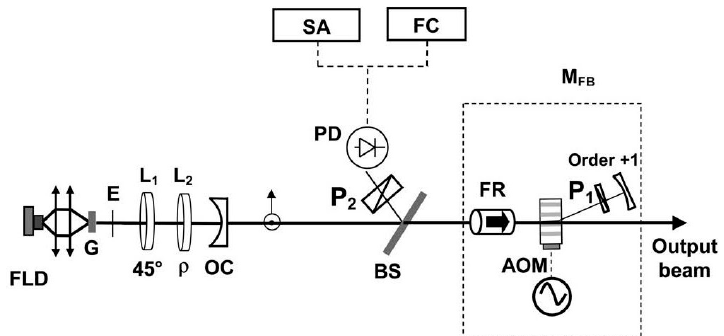
Figure 37. Schematic of self-injection stabilization process for 1.53 μ m dual-frequency phosphate glass laser [51] . FLD: fiber-pigtailed laser diode; G: Yb:Er glass plate; E: intracavity etalon; L 1 and L 2 : quarter-wave plates; P 1 and P 2 : linear polarizers; OC: output coupler; BS: beam splitter; FR: Faraday rotator; AOM: acousto-optic modulator; PD: photodiode; SA: spectrum analyzer; FC: frequency counters; M FB : optical feedback module; ρ : angular adjustment.